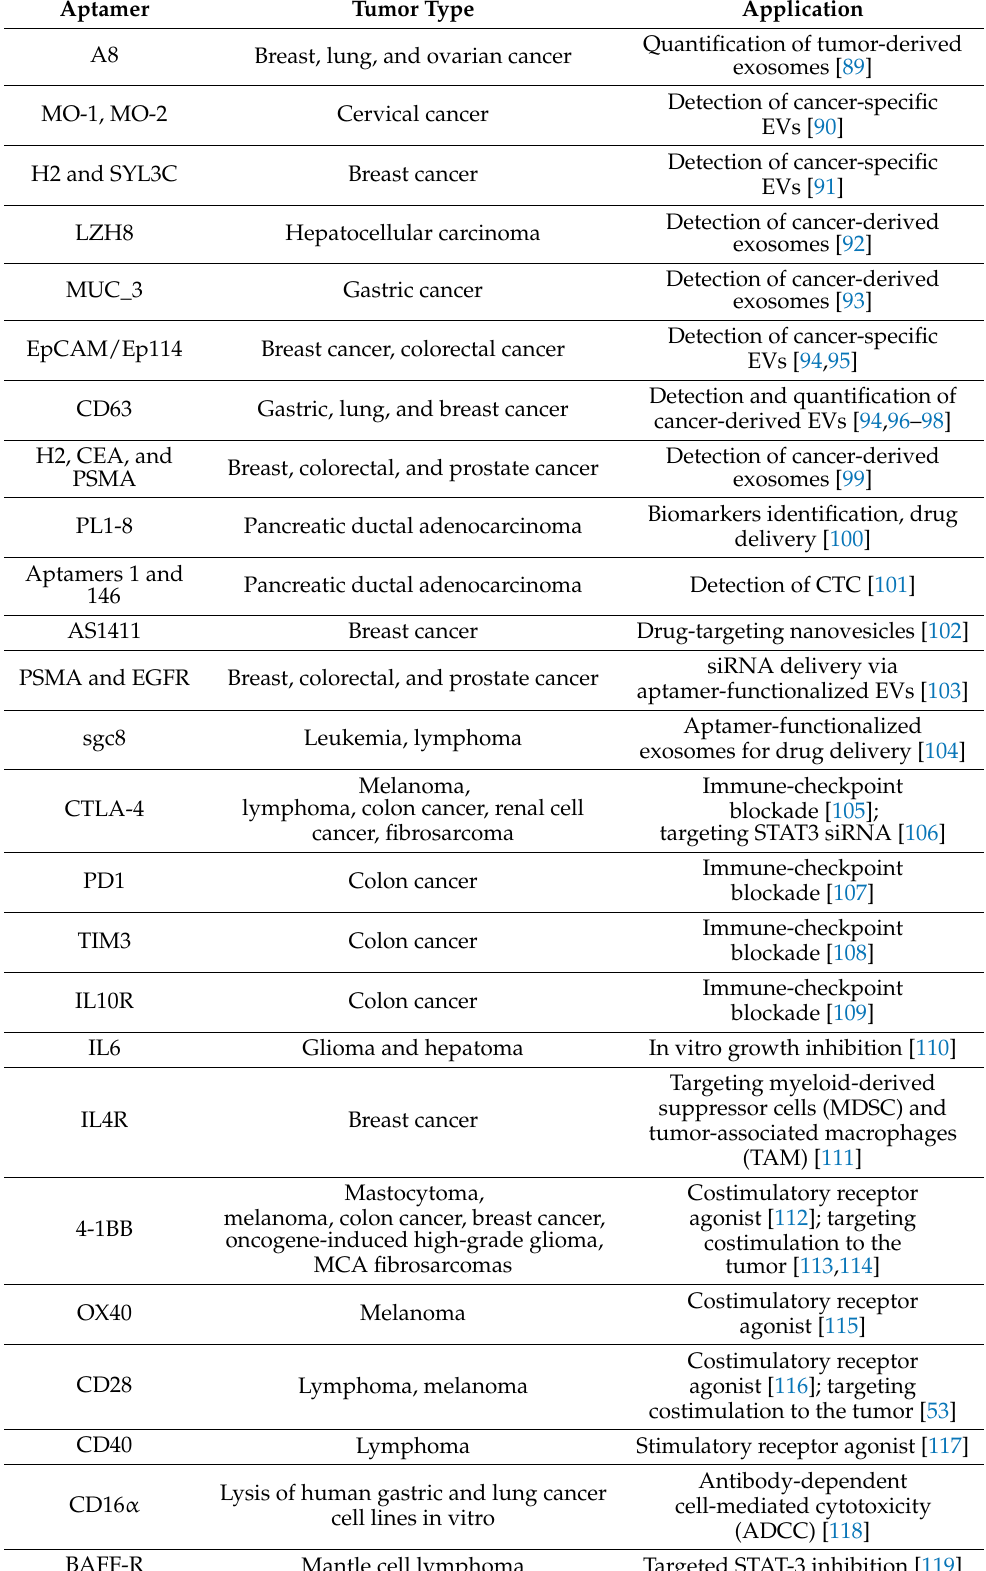
Table 1. A List of Selected Aptamers Used in Liquid Biopsy by Cancer